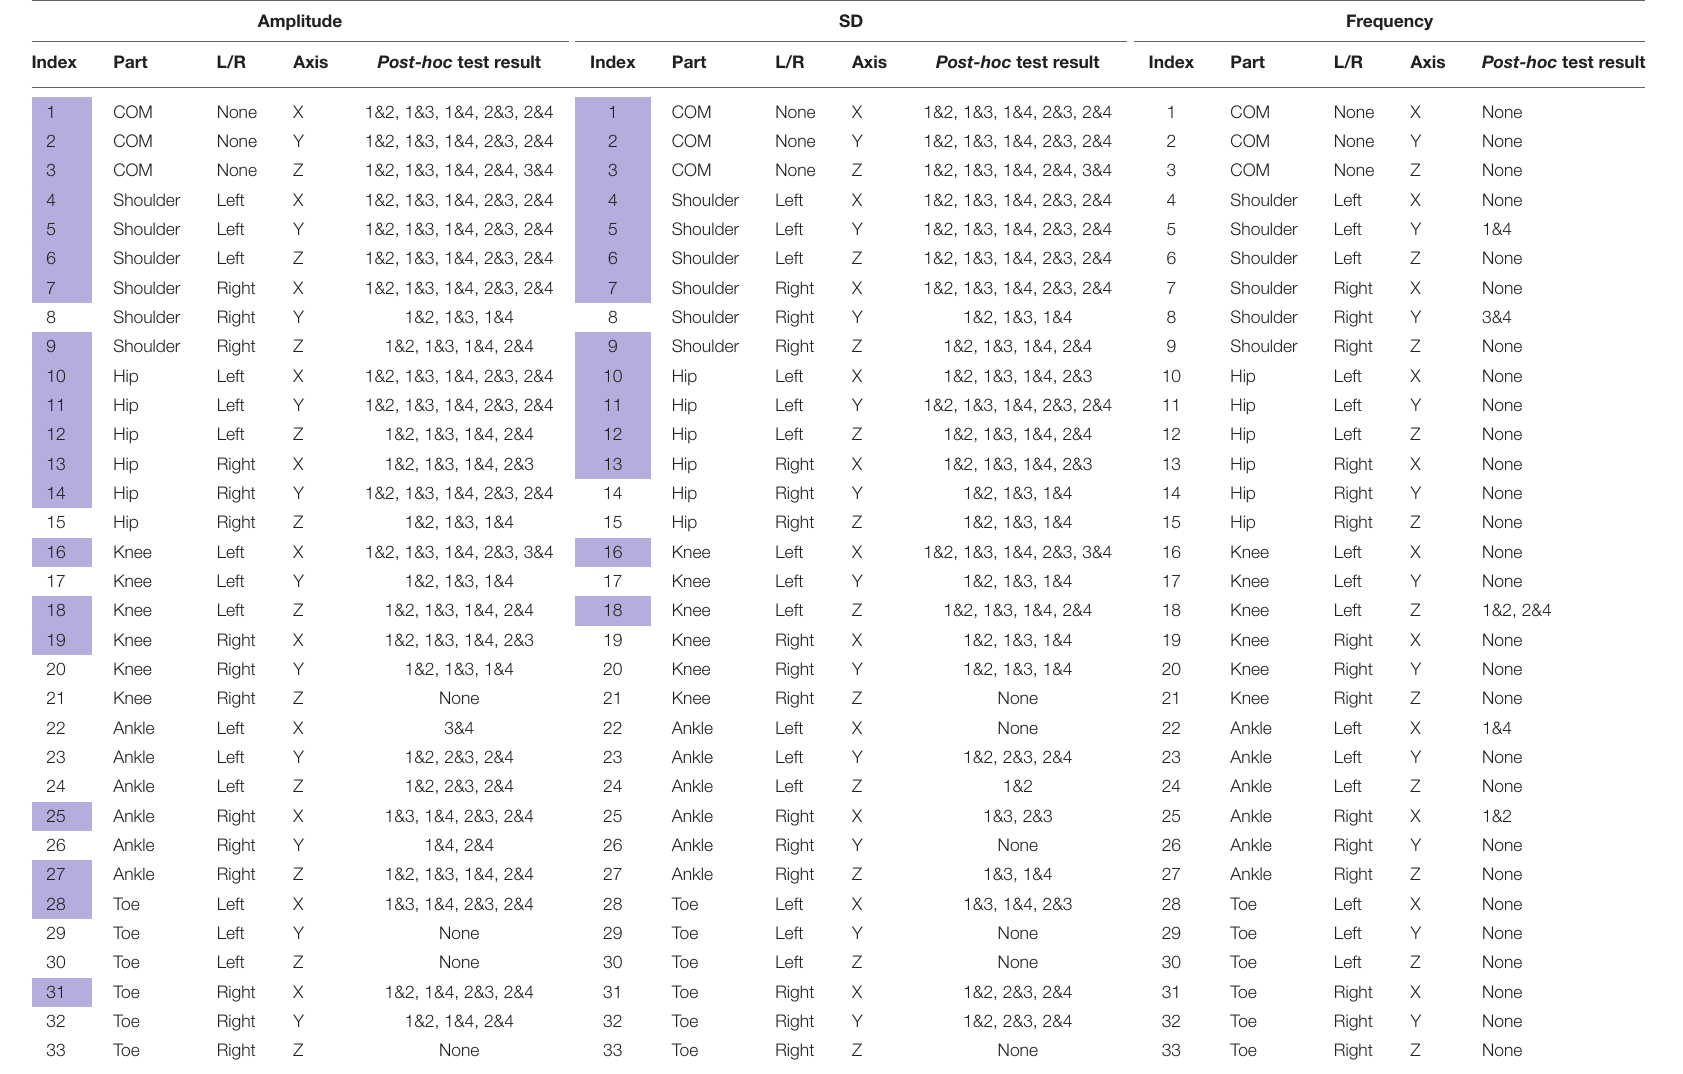
TABLE 5 | Post-hoc test results for each axis of each body on the left or right side to determine significant kinematic